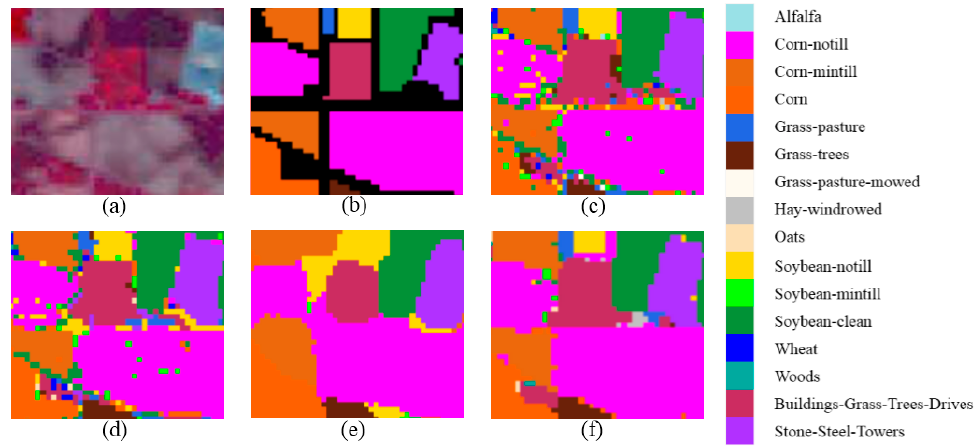
Figure 13. Zoom of classified region. ( a ) False-color composite. ( b ) Ground truth. ( c ) SAE-LR,